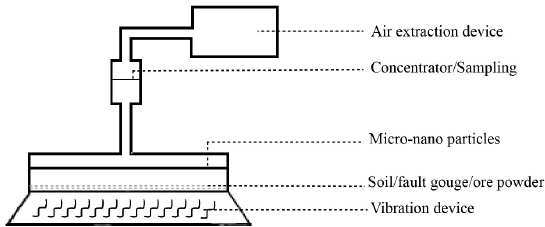
Figure 2. Diagram of soil fine particle separation device.